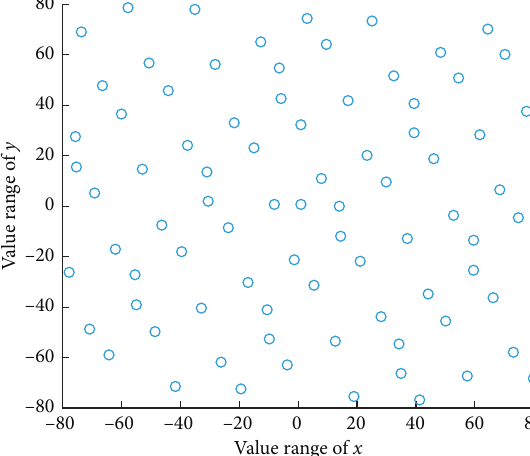
Figure 2: Flowchart of standard